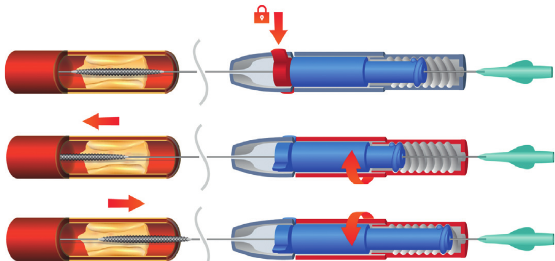
Figure 3: Locking and using the SPAS to move the stent to the accurate location in the artery: clockwise rotation drives the stent distally in the artery, and counter clockwise rotations retrieve the stent proximally.